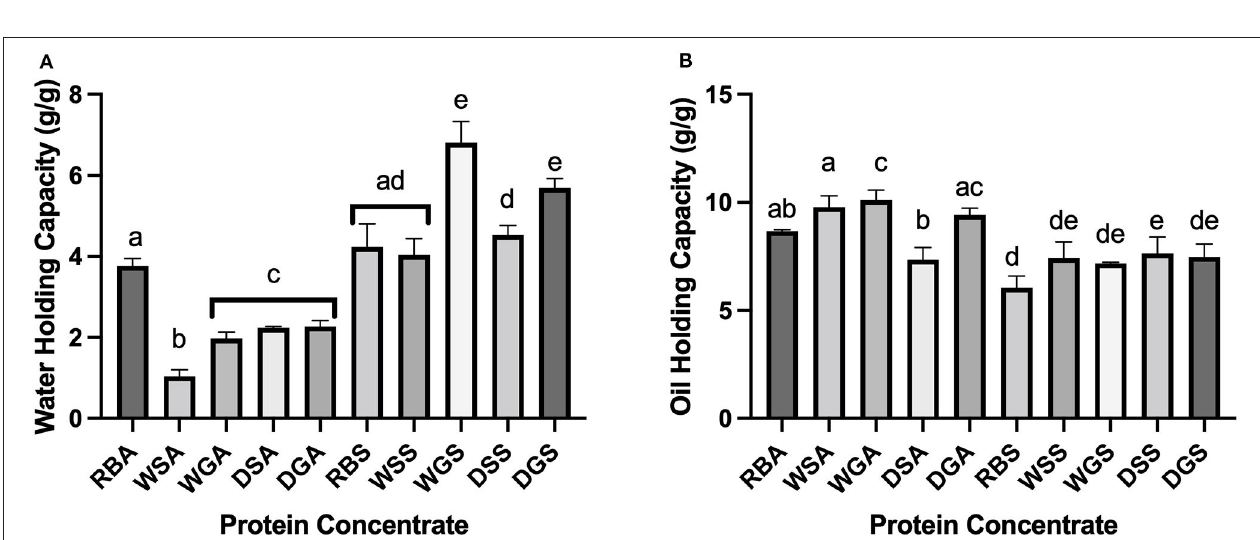
FIGURE 6 | (A) Water holding capacity of alkaline- and salt-extracted Yellow Eye bean protein; (B) Oil holding capacity of alkaline- and salt-extracted Yellow Eye bean protein concentrates. Different letters (a to e) represent significant differences by Tukey’s multiple comparison test ( p < 0.05), ( n =